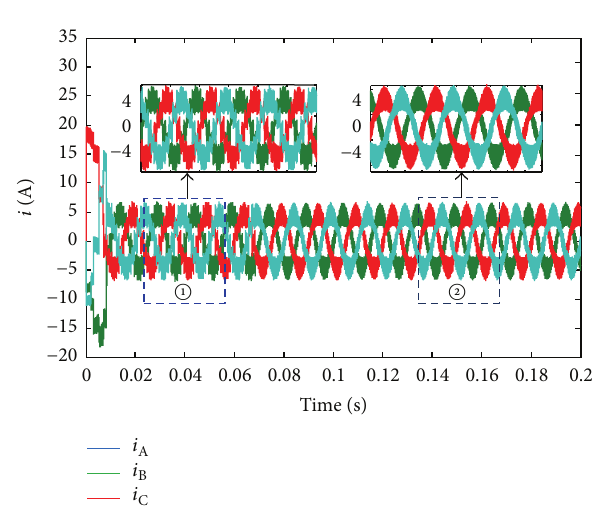
Figure 8: Simulation waveforms of three-phase stator